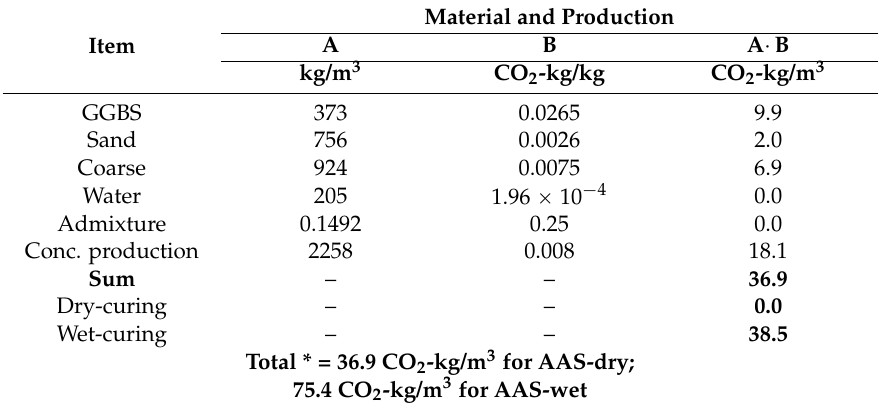
Table 7. CO 2 evaluation of AAS concrete.